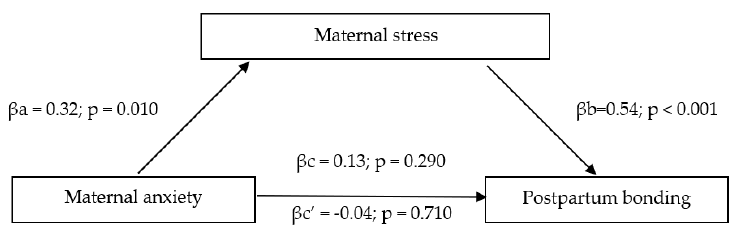
Figure 2. Mediating model of maternal anxiety on maternal postpartum bonding via maternal stress.